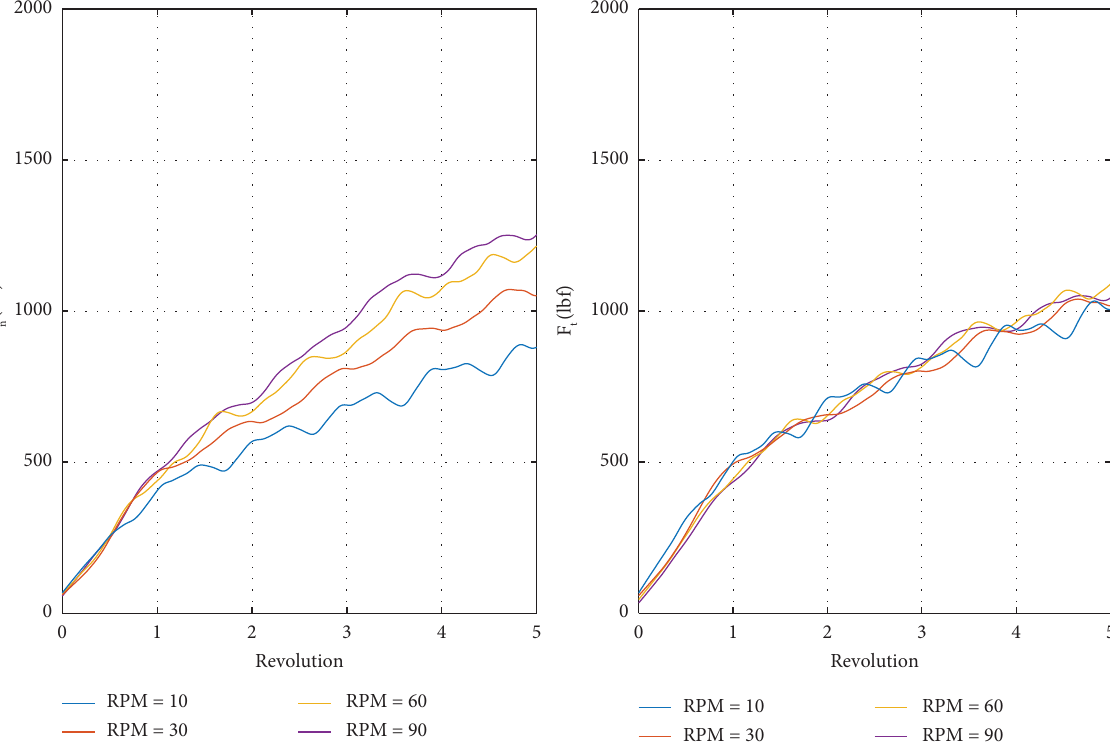
Figure 3: Smoothed axial ( F n ) and tangential ( F t ) cutting forces with various cutting